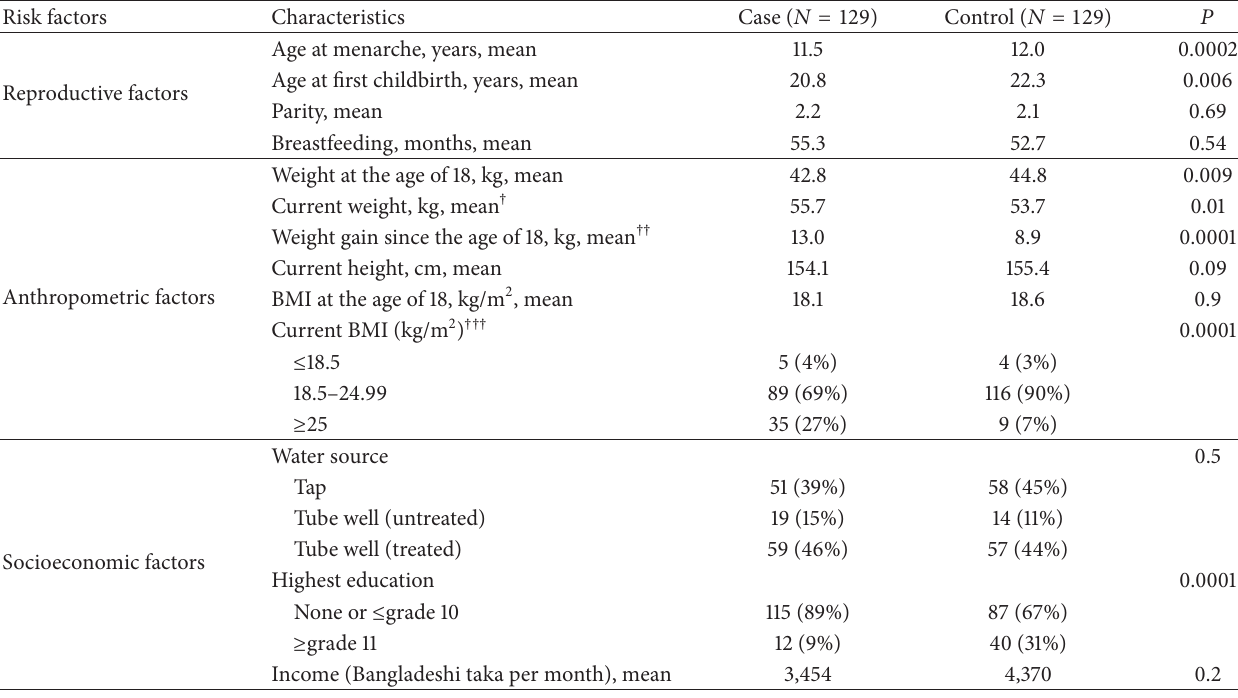
Table 1: Characteristics of breast cancer cases and matched controls.